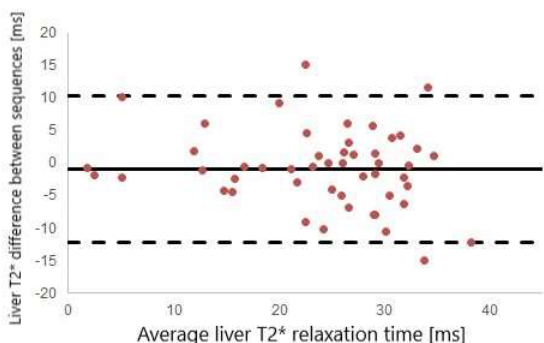
Figure 2. Bland–Altman plot of liver T2* values measured using a dedicated multi-echo gradient echo sequence and cardiac T2*map.